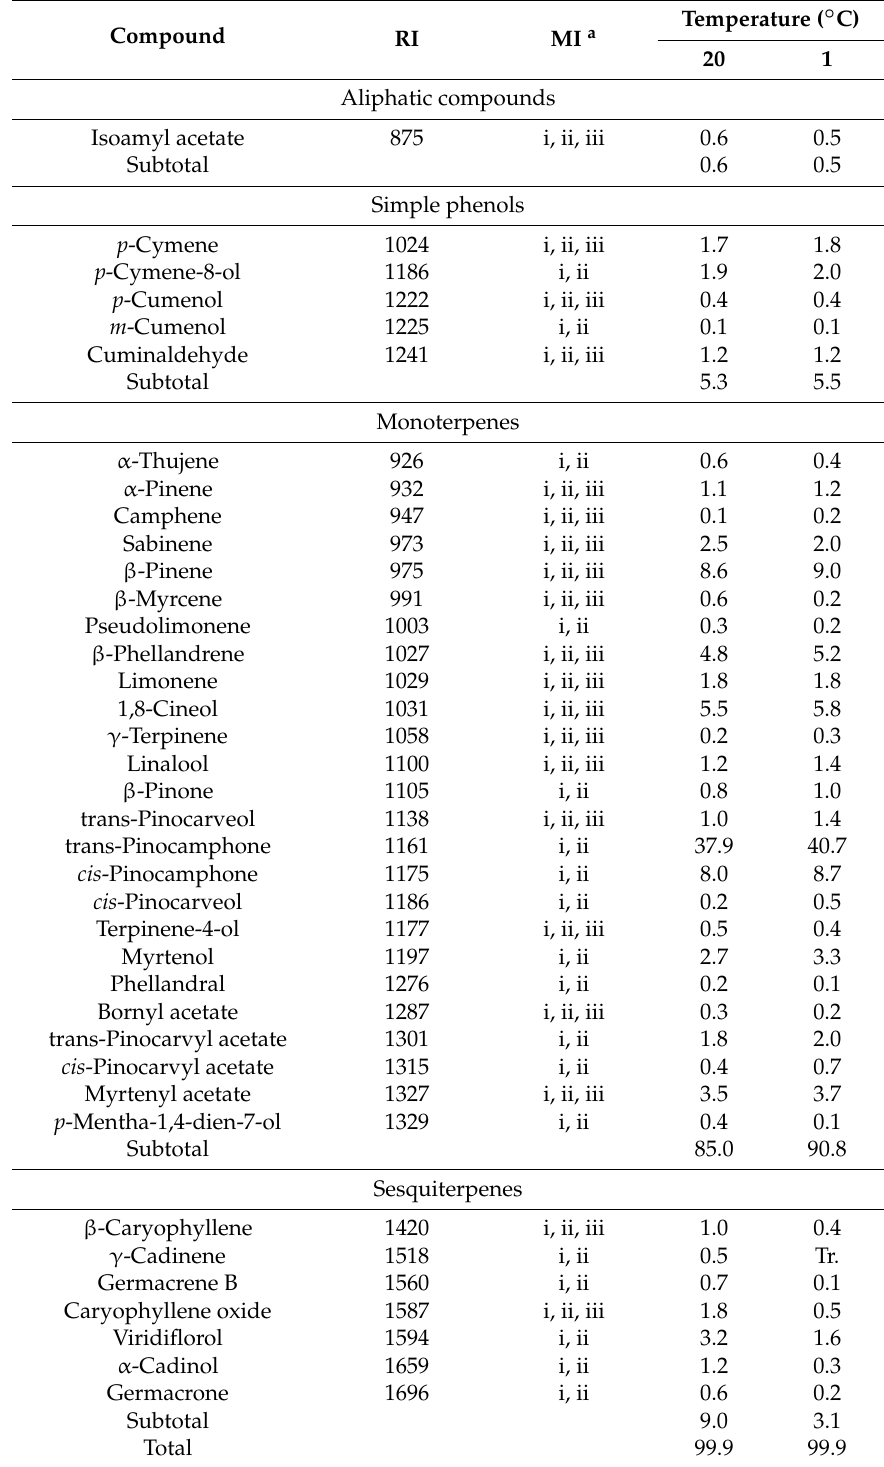
Table 3. Essential oil (EO) composition (percentage of total component content) of D. palmatum herb under different temperatures of